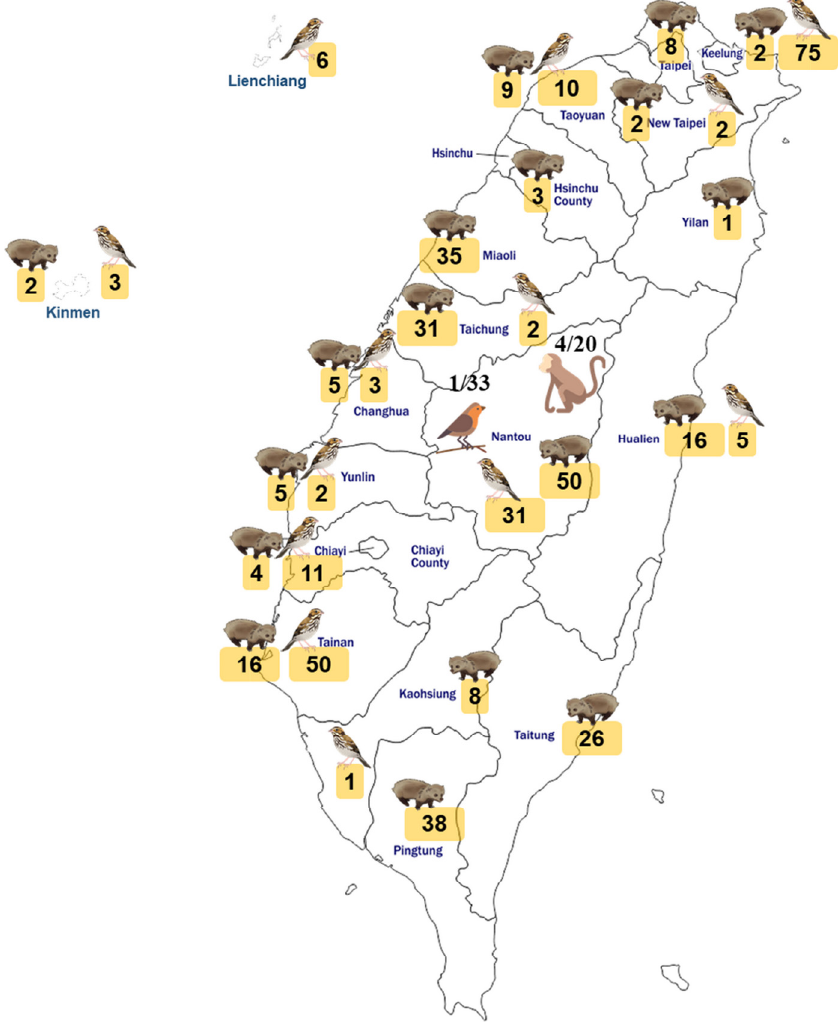
Figure 3. Map of Taiwan showing the location and number of wildlife enrolled in the study for SFTSV viral RNA detection. In total, 521 serum or tissue samples were collected from 263 mammals, and 258 birds were collected from all over the nation in 18 cities of Taiwan.